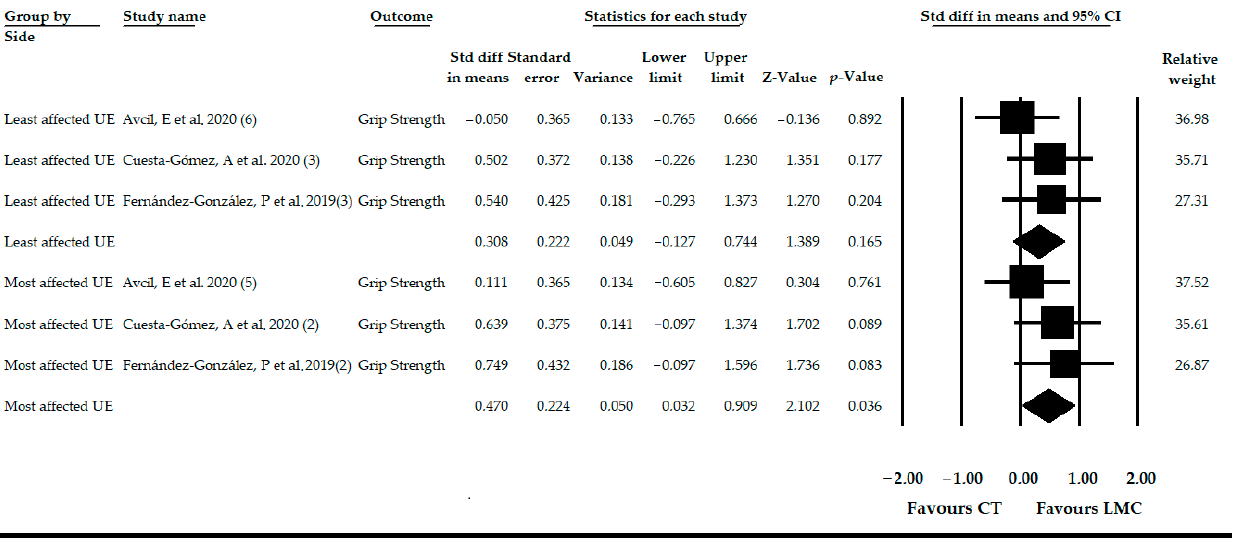
Figure 3. Forest Plot of the effect of LMC-based therapy on recovery of grip strength in patients with non-acute central nervous system disease (CNSD). Sensors 2021 , 21 , x FOR PEER REVIEW